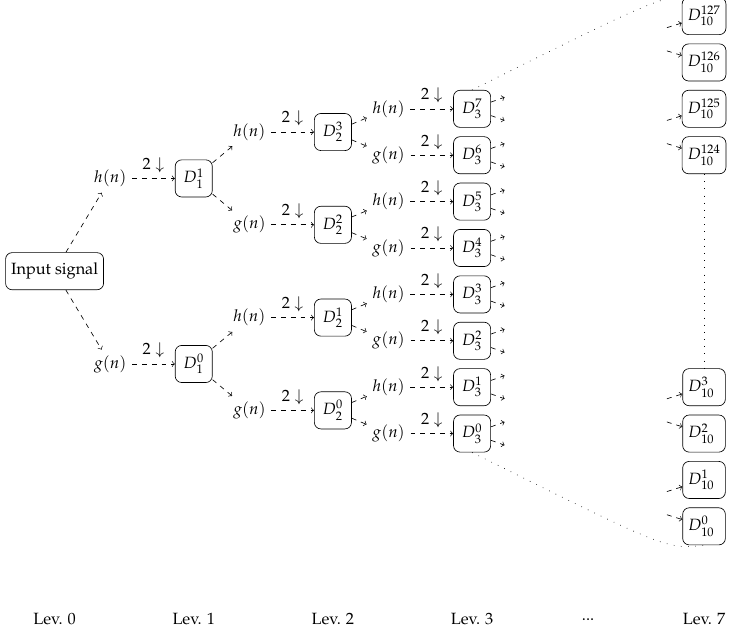
Figure 1. Wavelet Packet Decomposition (WPD) filtering and decimation scheme.